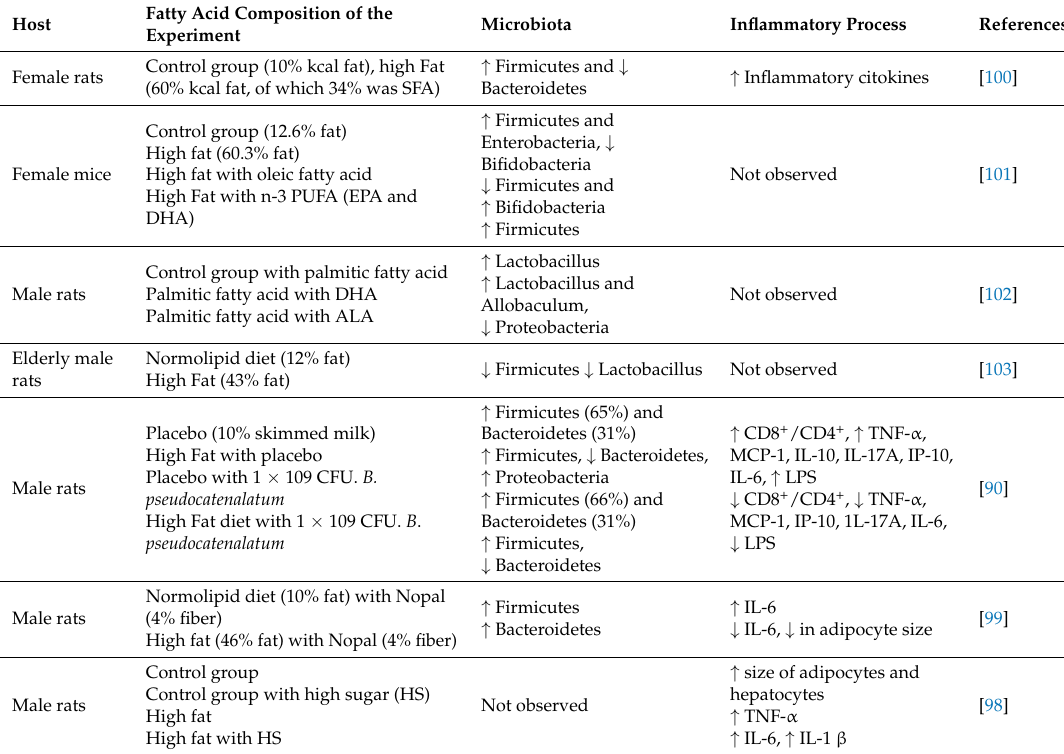
Table 6. Effects of different types of fatty acids on the inflammatory process and intestinal microbiota in in vivo